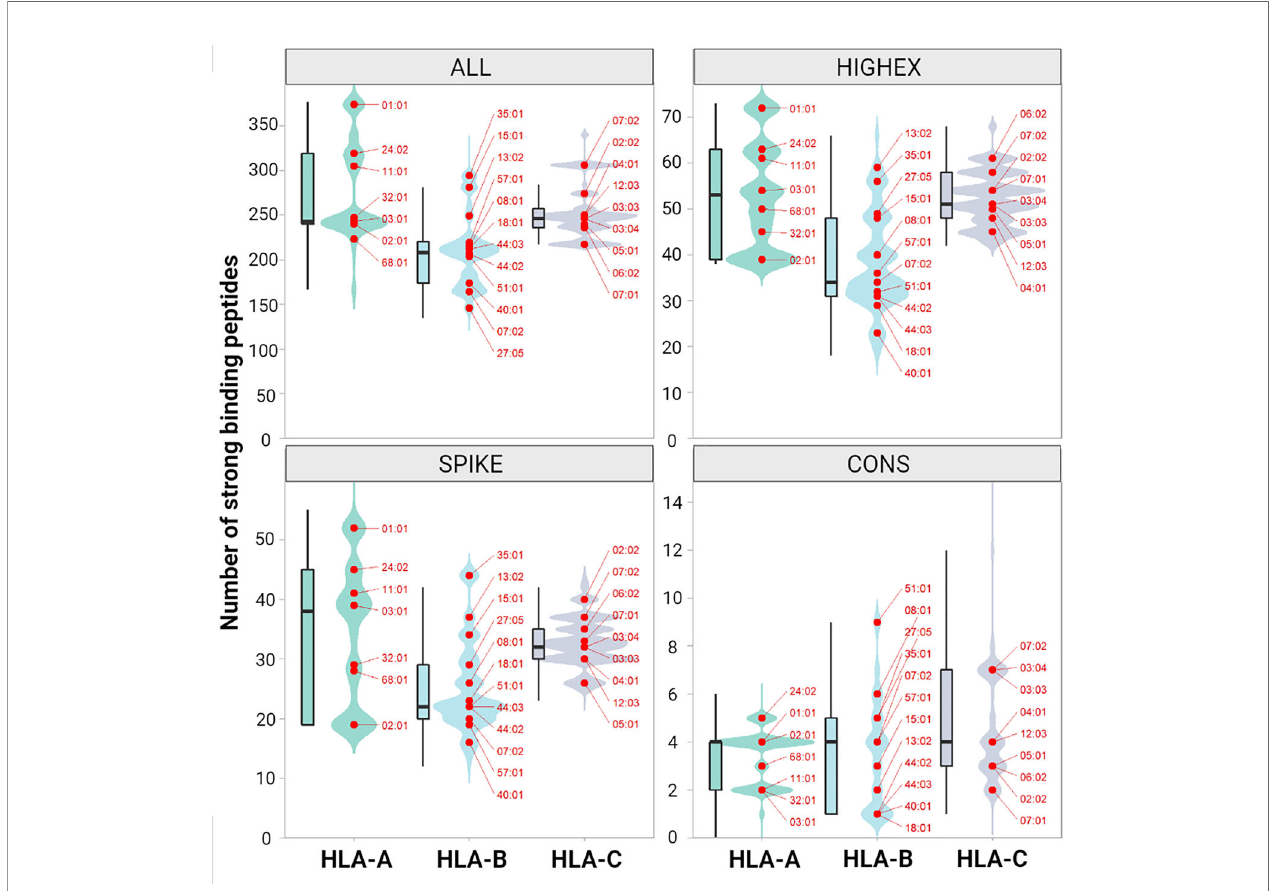
FIGURE 4 | Numbers of predicted immunogenic peptides per HLA class I molecule. The fi gure shows the distribution of the number of binding peptides across all patients and both alleles for HLA-A, -B and -C. The distribution is shown both as kernel density plot and as boxplot for peptides derived from the entire peptidome (ALL, upper left panel), from highly expressed proteins (HIGHEX, upper right panel), from the spike glycoprotein (SPIKE, lower left panel) and from conserved regions (CONS, lower right panel). The most common alleles are highlighted as red dots. The ranks of the most common allotypes re fl ect their capacity to present immunogenic peptides of the respective peptide pool, whereas the relative amplitude re fl ects the frequencies of all allotypes with this speci fi c capacity in the population. Changes in the ranks of the allotypes re fl ect a polarization of the respective peptide